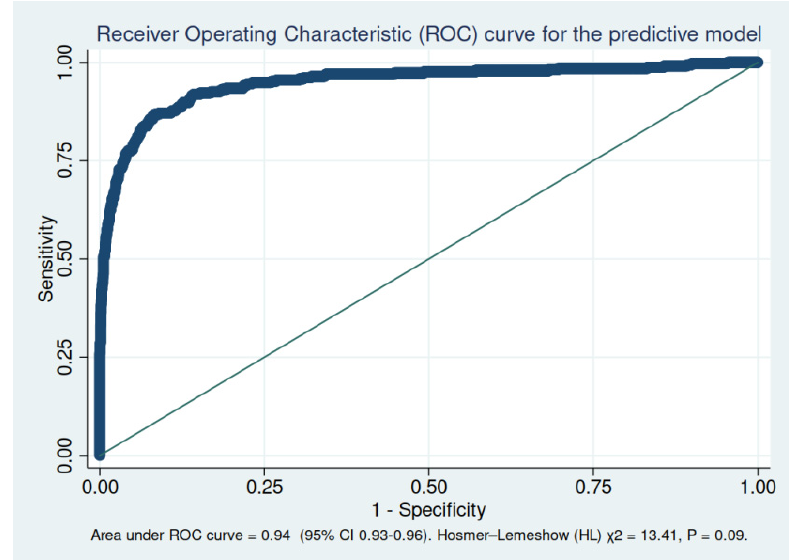
Figure 2. Receiver operating characteristic (ROC) curve for the predictive model.